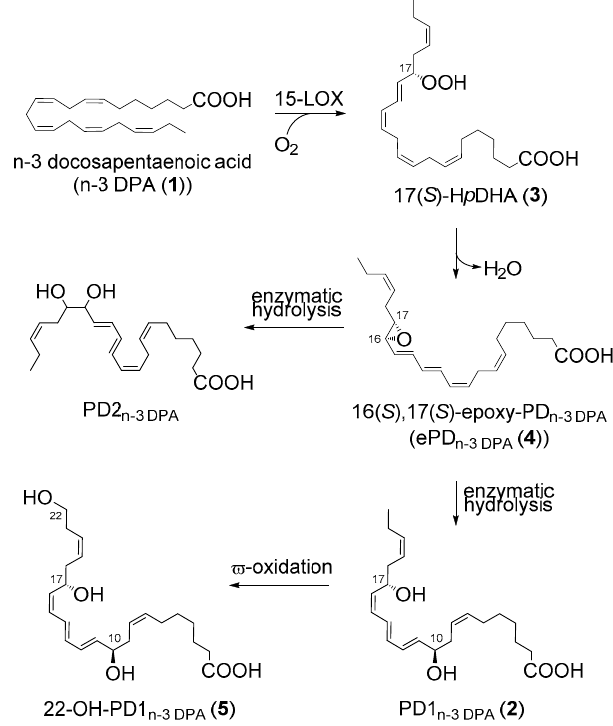
Figure 2. Chemical structures of some n-3 DPA derived SPMs. Where known, the absolute configuration is included.